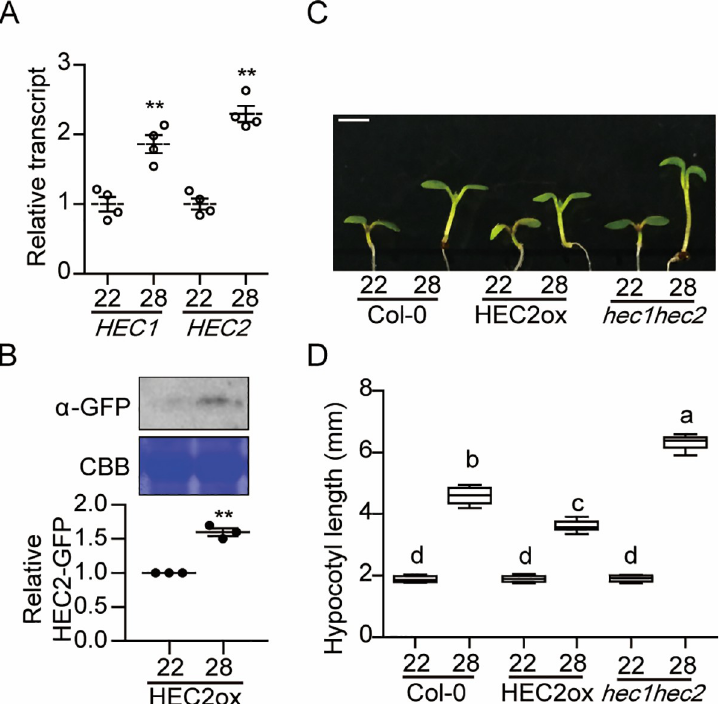
Fig 1. HEC s inhibit thermomorphogenesis. (A) The expression of HEC1 and HEC2 is upregulated by high ambient temperature. RT-qPCR samples were from Col-0 whole seedlings grown for 5 days at 22˚C and then either kept at 22˚C or transferred to 28˚C for 24 hours. Four biological repeats were performed. Relative gene expression levels were normalized using ACT7 . (B) Western blot shows the level of HEC2-GFP from 35S : HEC2-GFP whole seedlings grown for 5 days at 22˚C and either kept at 22˚C or transferred to 28˚C for 4 hours. Coomassie staining was used as a loading control. The experiments were repeated three times with similar results as indicated in the bar graph in lower panel. (C) Photograph showing seedling phenotypes of 35S : HEC2-GFP and hec1hec2 in normal and high ambient temperature. Seedlings were grown for two days in continuous white light at 22˚C and then either kept at 22˚C or transferred to 28˚C for additional four days before being photographed. The scale bar represents 5 mm. (D) Box plot shows the hypocotyl lengths grown under the conditions described in (C). More than 10 seedlings were measured for each experiment and was repeated 3 times. The letters a-d indicate statistically significant differences based on one-way ANOVA analysis with Tukey’s HSD test. Tukey’s box plot was used with median as a center value. The experiments were repeated more than three times with similar